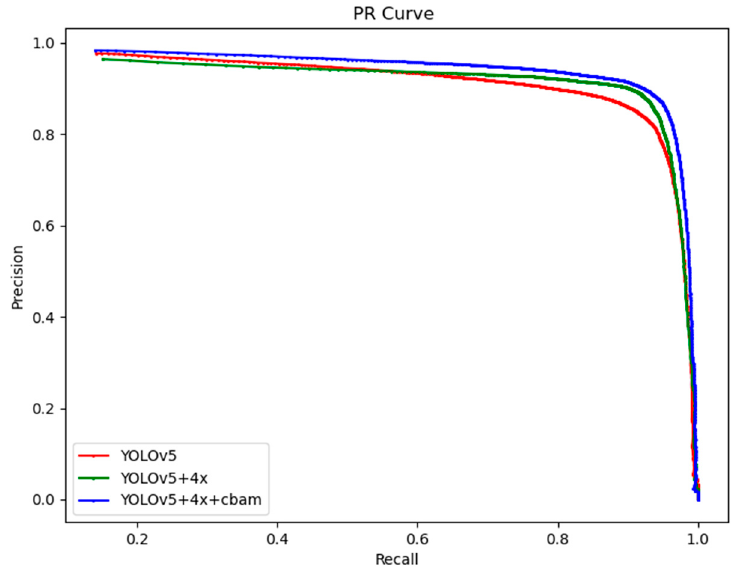
Figure 17. Precision recall curves of the detection results of different algorithms.